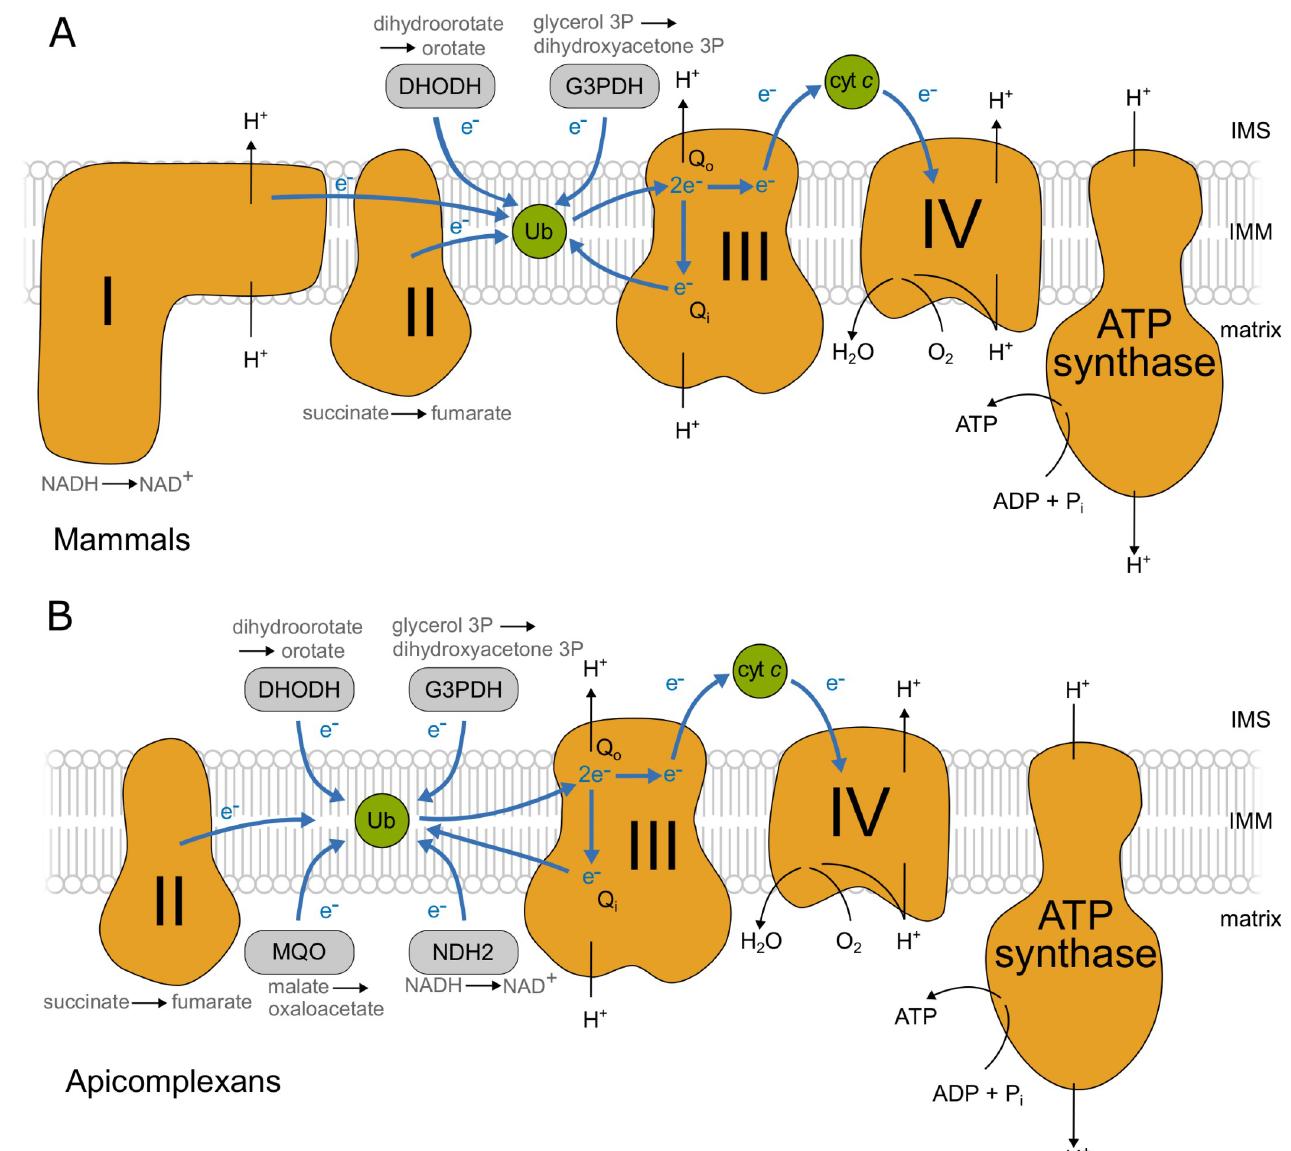
Fig 1. mETC and F 1 F o -ATP synthase in mammals and apicomplexans. A schematic showing the main features of the mitochondrial electron transport chain (mETC) and ATP synthase in mammals (A) and in apicomplexans (B). The four complexes are depicted in orange (Complex I: NADH:ubiquinone oxidoreductase; Complex II: succinate dehydrogenase; Complex III: cytochrome bc 1 complex; Complex IV: cytochrome c oxidase; and F 1 F o -ATP synthase). Mobile electron carriers (ubiquinone/ubiquinol and the intermembrane space protein cytochrome c ) are depicted in green. Main alternative entry points (the dehydrogenases DHODH: dihydrooratate dehydrogenase; G3PDH:glycerol 3-phosphate dehydrogenase; MQO:malate:quinone oxidoreductase and NDH2: type 2 NADH dehydrogenase ( Toxoplasma possesses two copies)) are depicted in grey. The path of electron flow across the mETC complexes is depicted by blue arrows and the path of protons across the inner mitochondrial membrane (IMM) from the matrix to intermembrane space (IMS) and back is depicted with black arrows. https://doi.org/10.1371/journal.ppat.1009301.g001 and cytochrome c to the mobile cytochrome c protein. All complexes III are structural dimers, 1 with the Rieske subunit crossing the dimer interface. Each monomer of the mammalian com- plex contains eight further ‘supernumerary’ subunits [25], and the yeast complex contains seven [26]. The subunit composition of complex III in apicomplexans is currently unknown. The three key conserved catalytic subunits, the cytochrome b , Rieske and cytochrome c 1